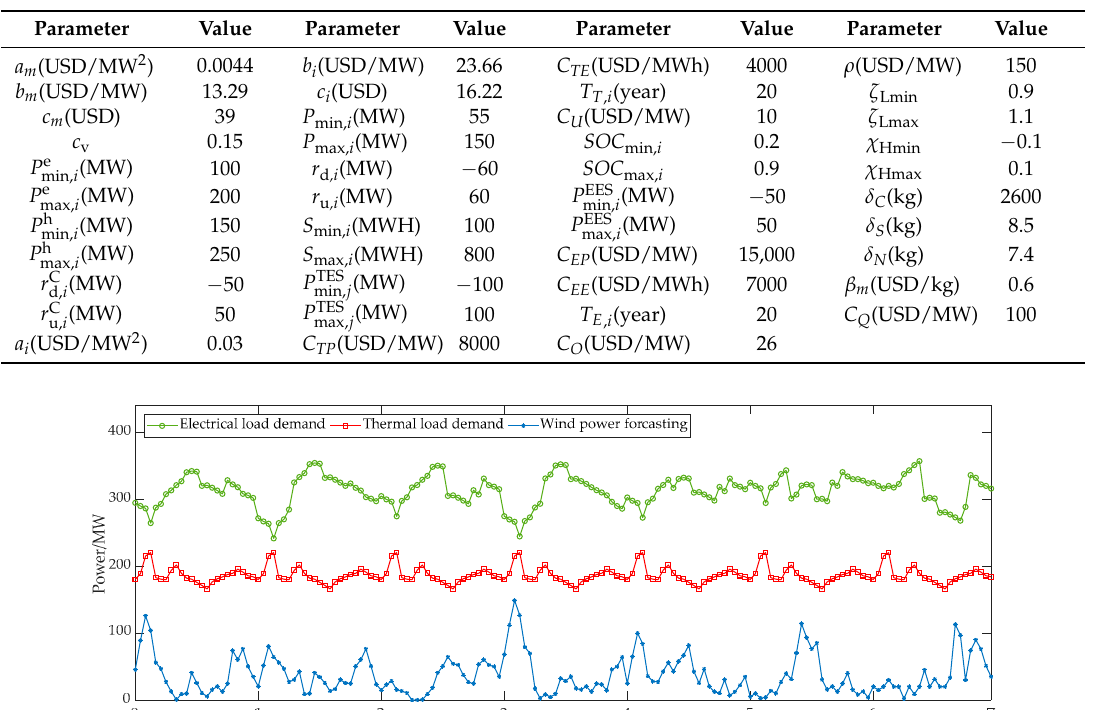
Table 1. The parameters of dispatch models.